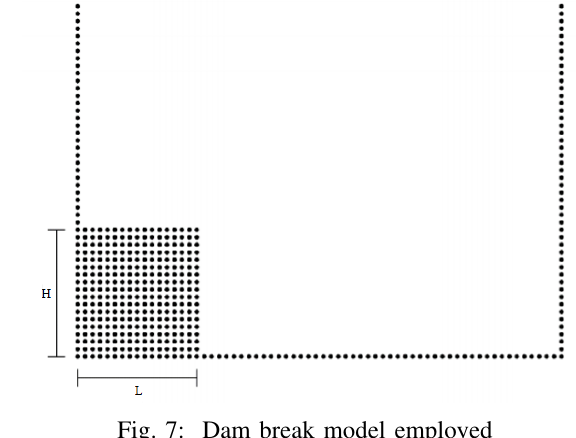
Fig. 7: Dam break model